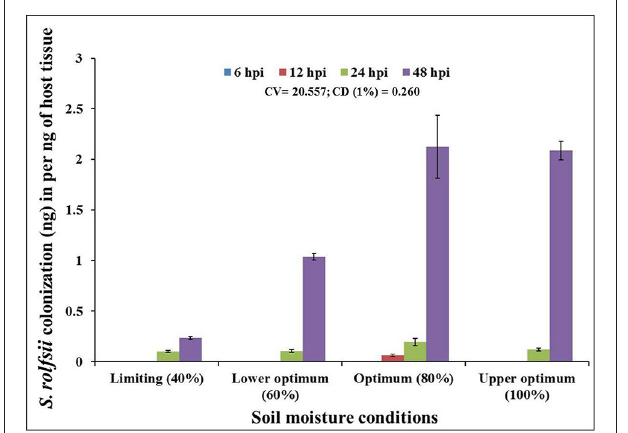
FIGURE 2 | Chronological colonization profile of S. rolfsii in shoot tissues of inoculated chickpea (cv. Annigeri) grown in different soil moisture conditions. Absolute quantification of fungal DNA was determined in real-time PCR assay using sequences of 5.8S rDNA. Error bar represents the standard error of three biological replications at 95% confidence interval. The statistical significance between S. rolfsii growth and different soil moisture conditions was calculated by factorial